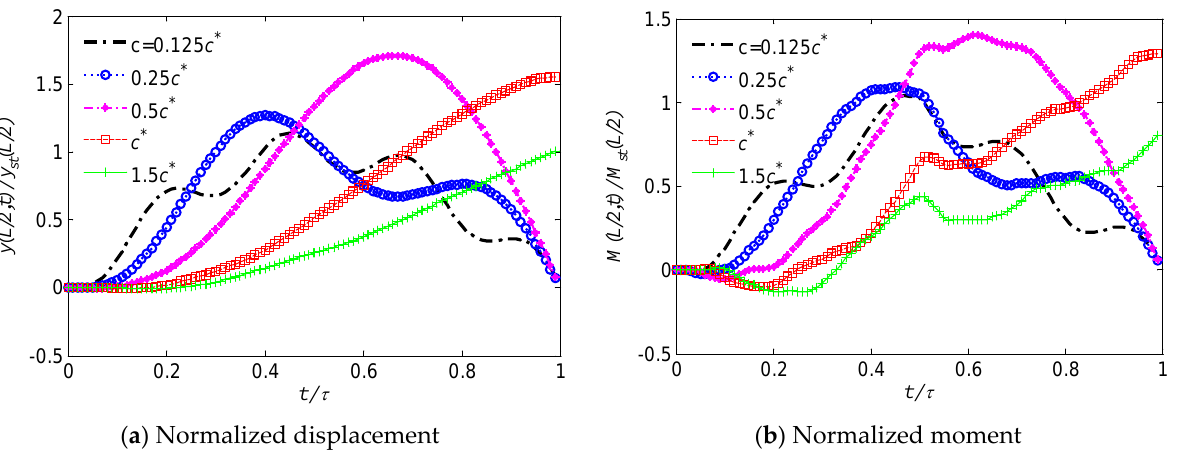
Figure 5. Mid-span displacement and moment of the beam with b = 0.03 and c = 0.125 c ∗ , 0.25 c ∗ , 0.5 c ∗ , c ∗ and 1.5 c ∗ .